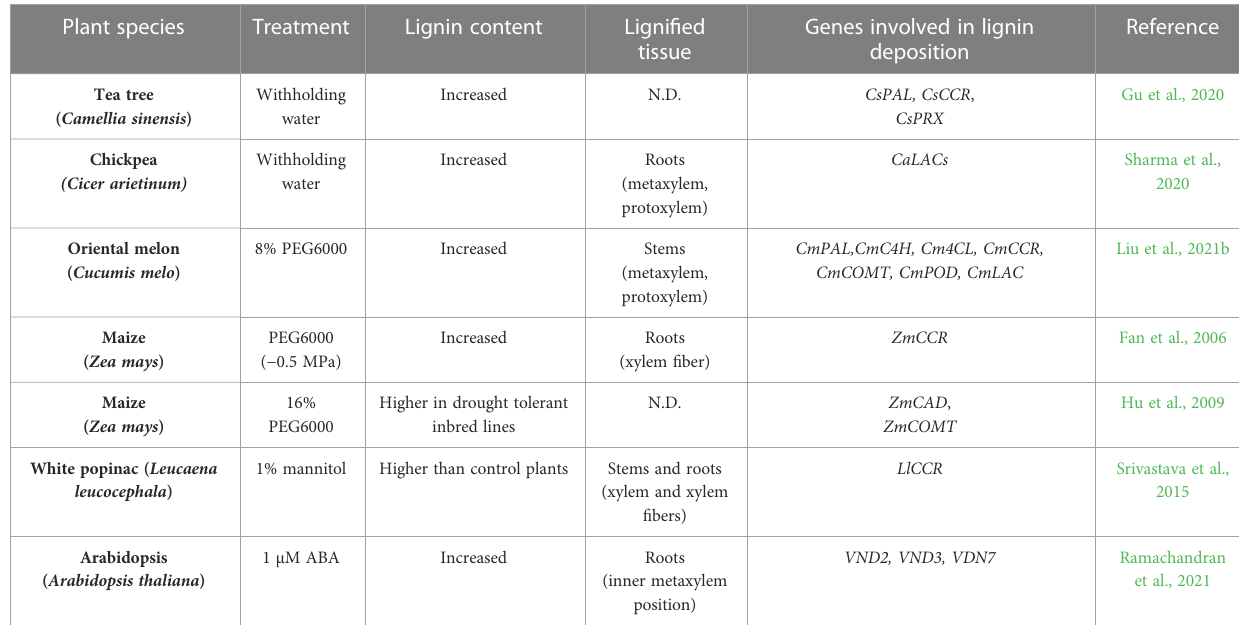
TABLE 1 Effect of drought treatments on lignin deposition in